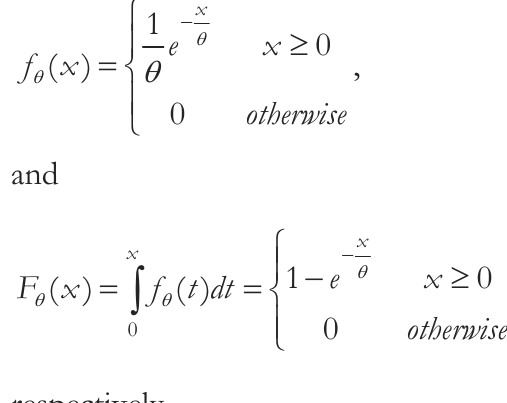
Power of Test 1 with SRSS data from the uniform distribution